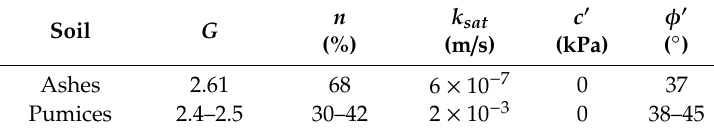
Figure 2. Stratigraphy observed on site and sensor positions. Table 1. Main physical properties of the investigated soils.